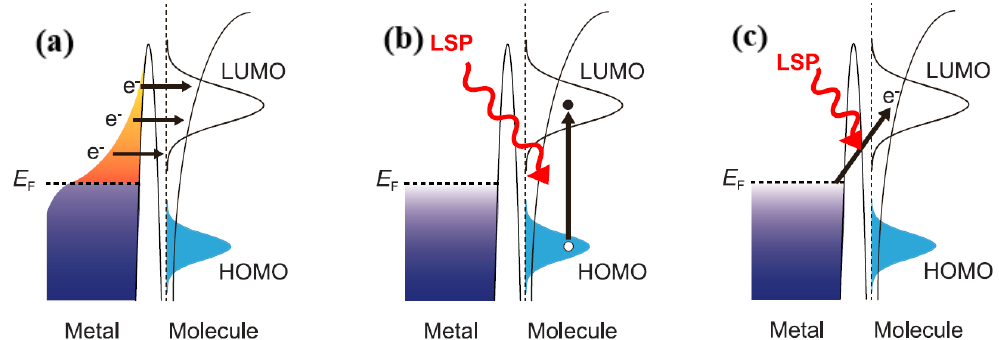
Figure 12. Excitation mechanisms for plasmon-induced chemical reactions. ( a ) Indirect hot-electron transfer mechanism. Hot electrons (e - ) generated via non-radiative decay of an LSP transferred to form the transient negative state (TNI) states of the molecule. ( b ) Direct intramolecular excitation mechanism. The LSP induces direct excitation from the occupied state to the unoccupied state of the adsorbate. ( c ) Charge transfer mechanism. The electrons are resonantly transferred from the metal to the molecule. Adapted from [13].